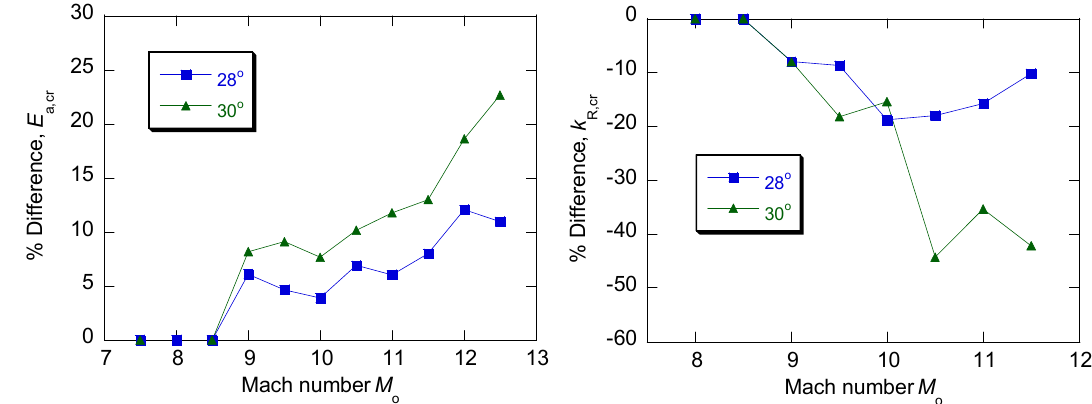
Figure 13. The percentage difference of E a,cr (left); and k R,cr (right) between the base case of θ = 26° and increasing wedge angles θ = 28° and 30°.